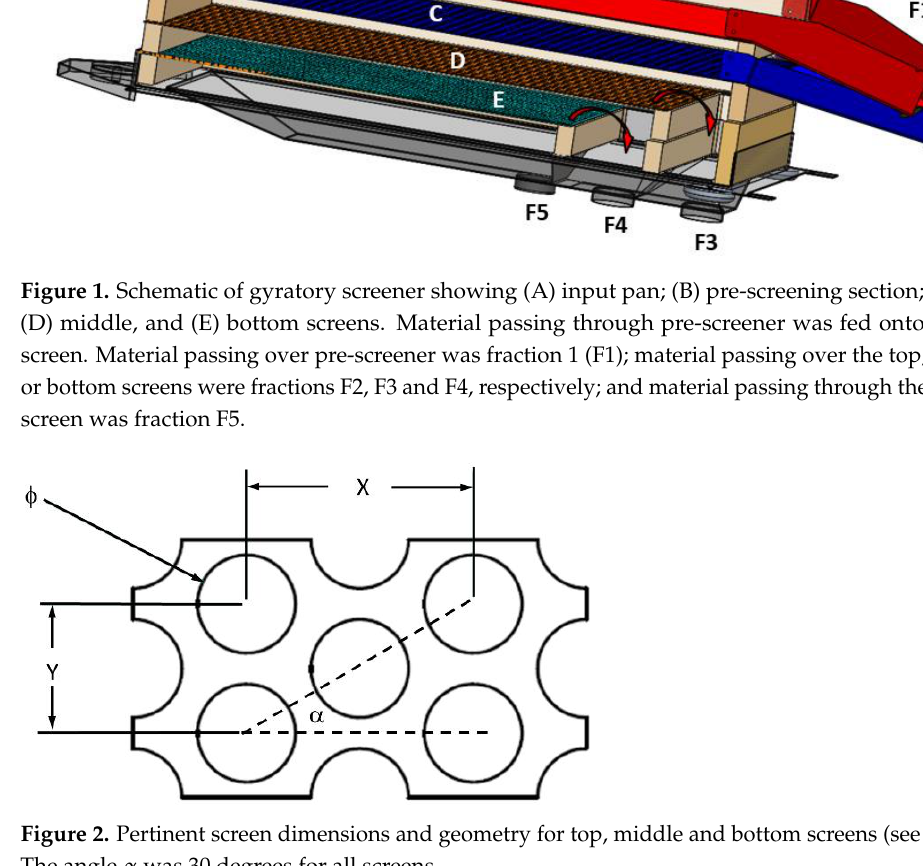
Figure 3. The gyratory screener with the fraction collection containers. 2.2. Experiments Conducted Two experiments were conducted on wheat harvested at the University of Wisconsin Arlington Agricultural Research Station using a John Deere (Moline, IL, USA) model 9860 STS combine. The crop residue was processed to varying extents by adjusting the residue chopper speed and residue chopper stationary knife engagement (Figure 4 and Table 2). Experiment 1 was a full factorial with two chopper speeds x two knife positions. Experi- ment 2 investigated three treatments: (1) no residue processing; (2) 0 mm knife engagement and 1600 rpm chopper speed; and (3) 90 mm knife engagement and 2500 rpm chopper speed. In Experiment 2, the first treatment was created by raising the residue chopper out of the path of material that exited the combine harvester. No other changes to the combine harvesters’ configuration were made once an experiment began. The header height was set at approximately 10 cm so that most of the plant was harvested and the crop height prior to harvest was approximately 80 and 90 cm tall in Experiments 1 and 2, respectively.